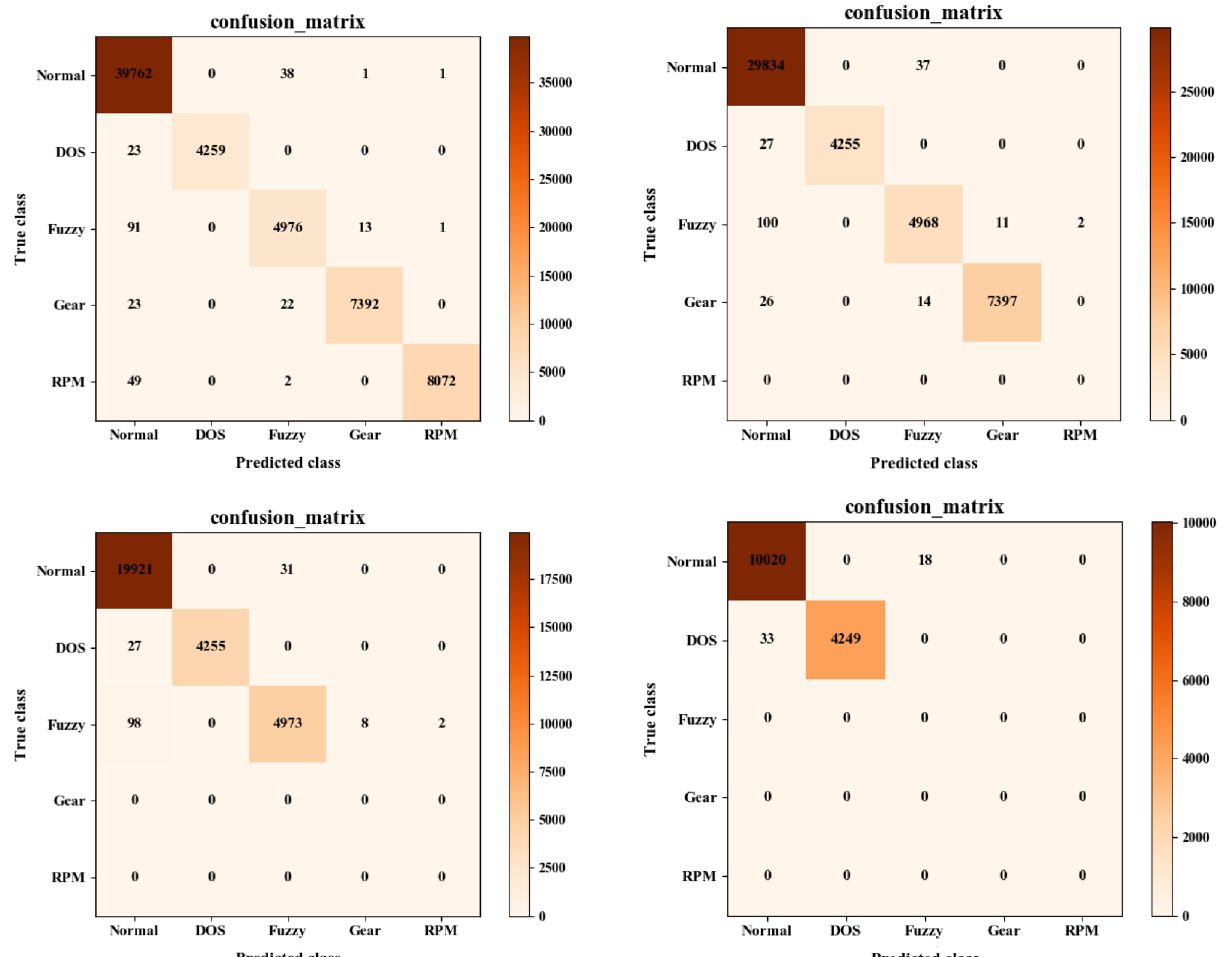
Figure 10. Results of the typical confusion matrices using Mosaic coding for 11-bit CAN ID. The numbers in the confusion matrix represent the number of samples from the original category represented by the horizontal axis being classified into the category represented by the vertical axis. For example, the intersection between Fuzzy (vertical) and Normal (horizontal) represents the number of Normal samples wrongly classified by the model as